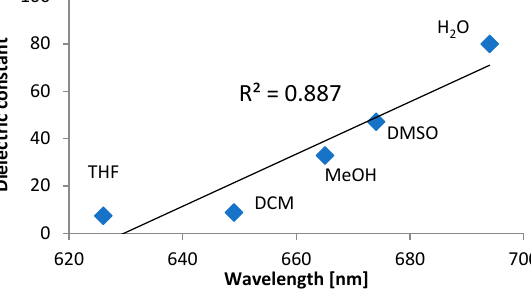
Figure 5. Correlation between maximum emission wavelength of DTTDO-DEA and solvent dielectric constant.